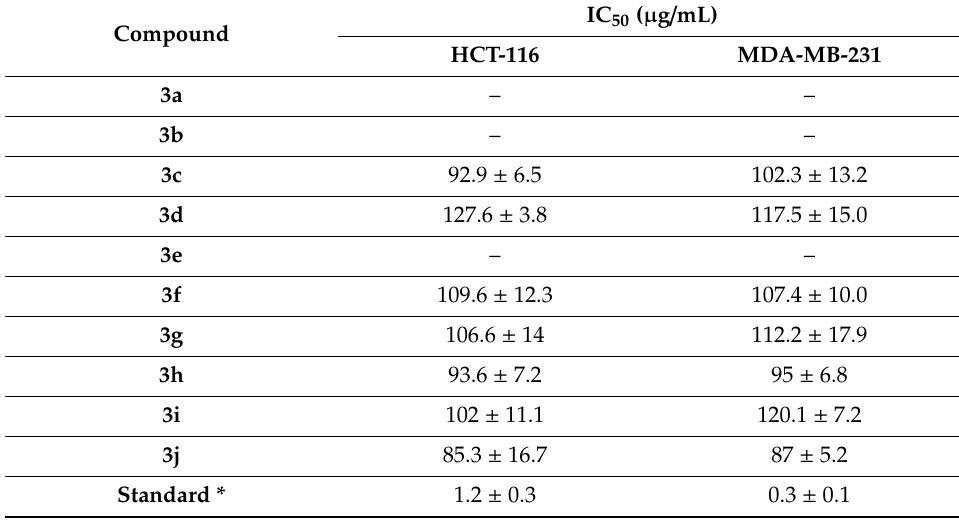
Table 3. Anticancer activity of compounds